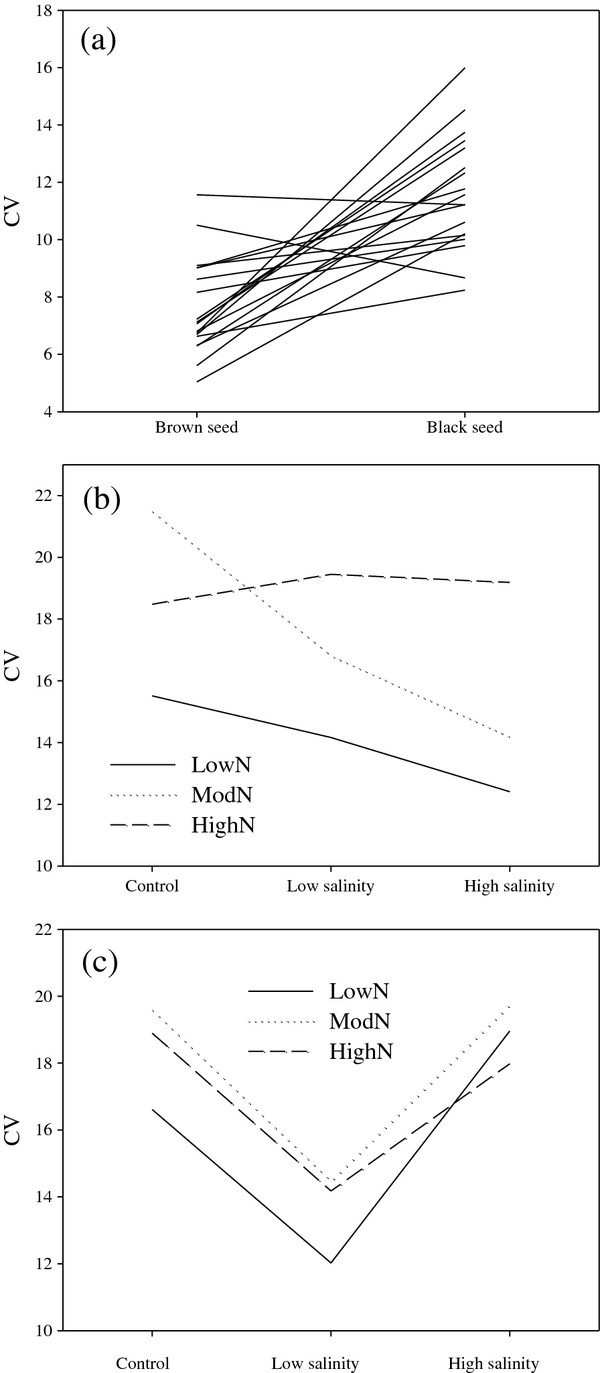
Reaction norm plots for different drivers of CV (coefficient of variation) of seed diameter. (a) Effect of seed type (brown seed or black seed) on CV in 18 treatments. Each line represents a treatment of Suaeda aralocaspica; (b) Effect of nutrient (low, moderate and high) and salinity (control, low and high) on CV for plant grown from brown seed and (c) for plant grown from black seed. N: Nutrient.